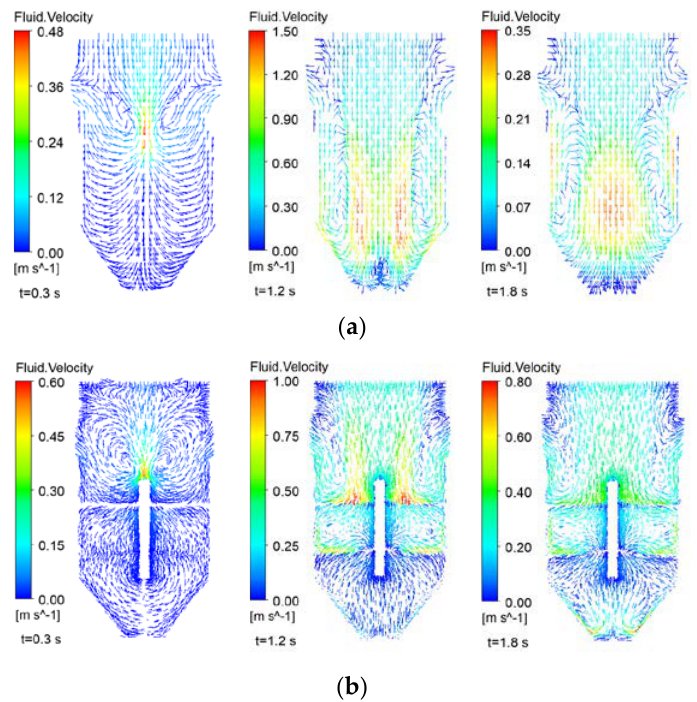
Figure 6. CFD results show velocity vectors at di ff erent times of ( a ) conventional hopper; ( b ) spiral hopper. Airflow is colored by velocity